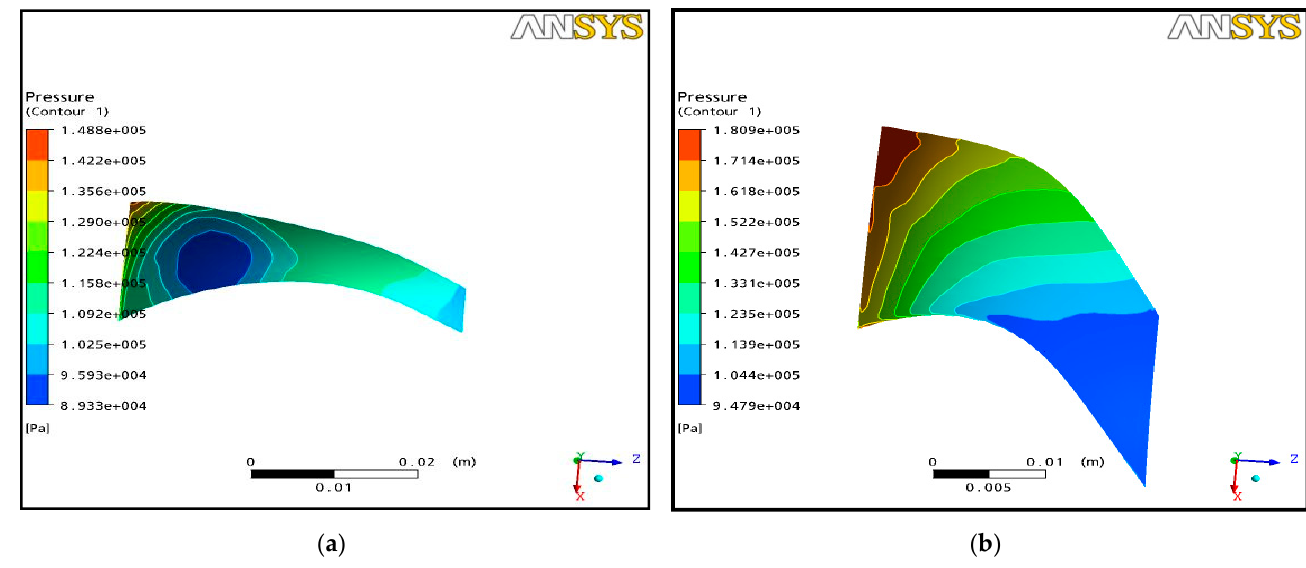
Figure 11. Static pressure contours: ( a ) hub; ( b ) shroud.